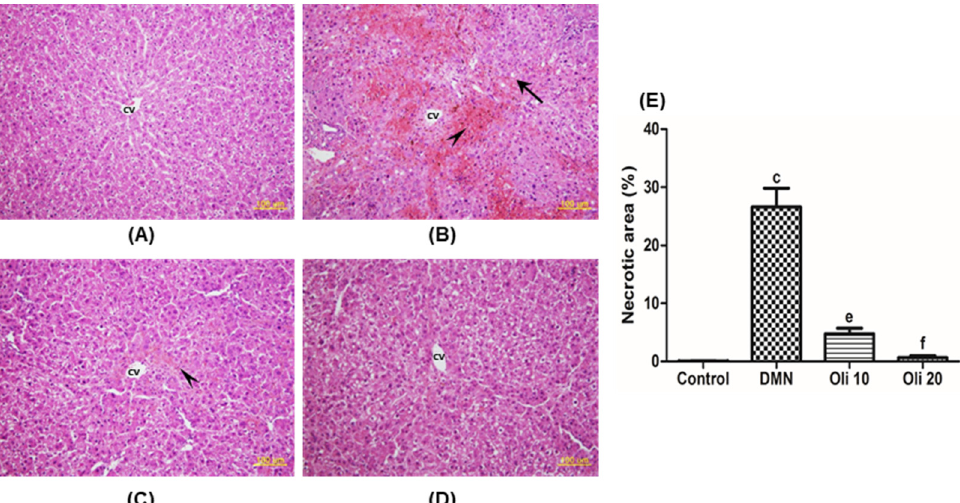
Figure 3. Effects of oligonol on dimethylnitrosamine (DMN)-induced histopathological changes in rat livers. H&E staining of liver sections from: ( A ) Control rats; ( B ) DMN-treated rats; ( C ) DMN-treated rats with oligonol (10 mg/kg); ( D ) DMN- treated rats with oligonol (20 mg/kg). ( E ) Quantitative analysis of necrotic area observed on H&E stained sections. c p < 0.001 vs. the control group, and e p < 0.01 and f p < 0.001 vs. the DMN group. CV: Central vein, arrowhead: Collagenous septa, arrows: Fatty changes. All images are original magnification ×